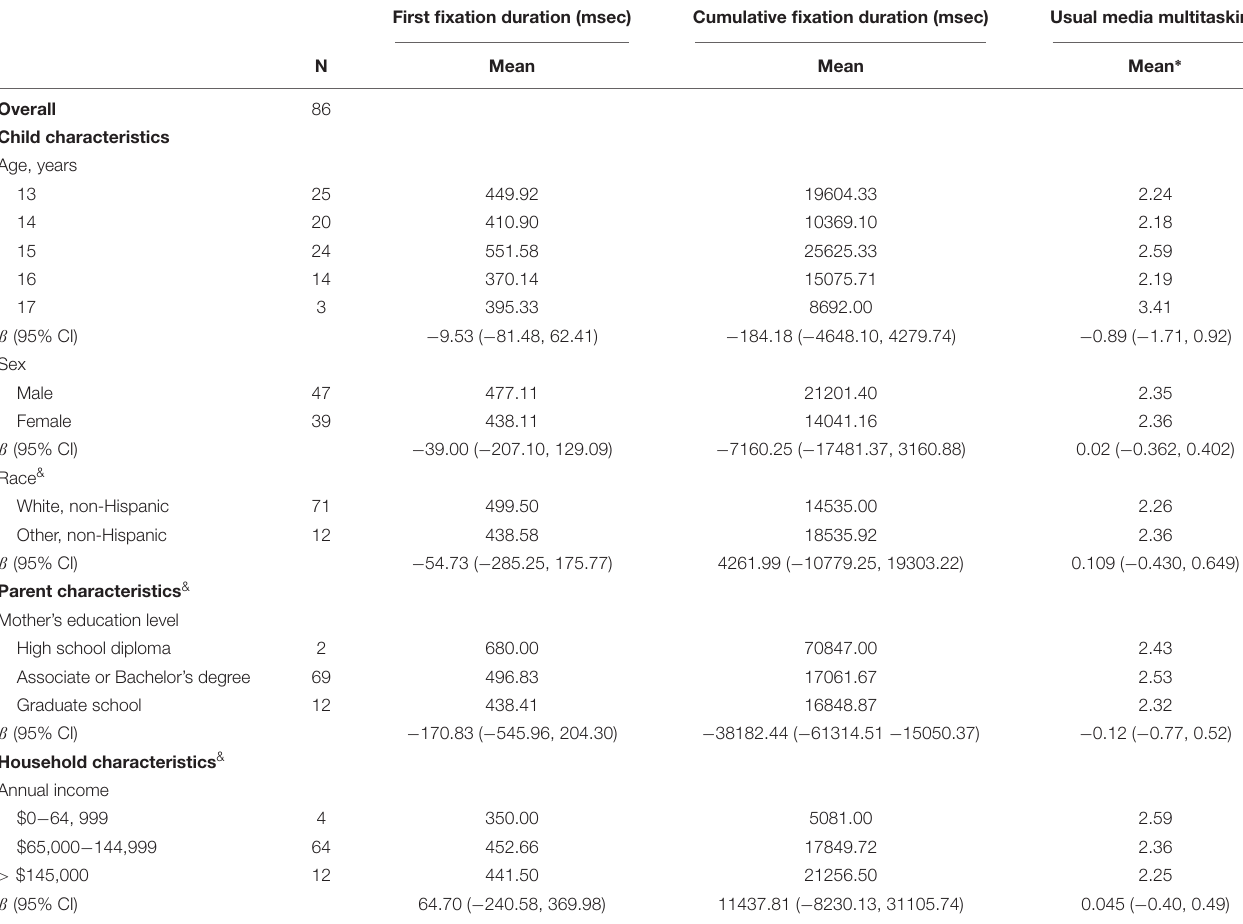
TABLE 1 | Distribution of attention metrics and usual media multitasking scores across child, parent, and household